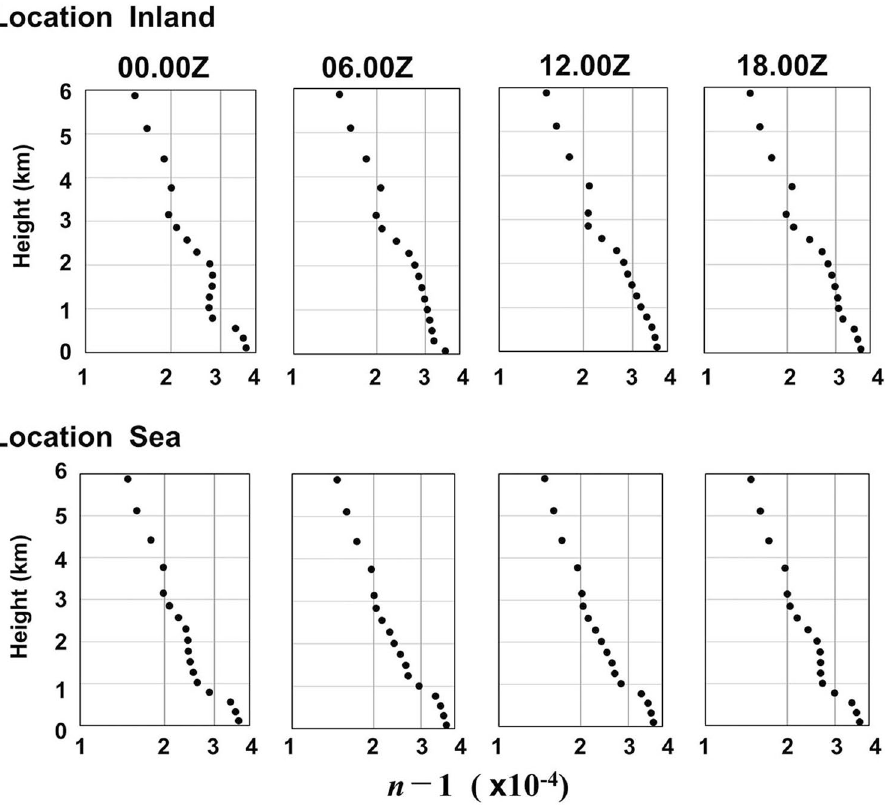
Figure 5. Diurnal changes of refractive indices calculated as a function of height, time and location using MERRA-2/NASA database of 15 October 2015. Locations are “inland” and “sea” of Fig. 4. (EXCEL 2019, Power Point